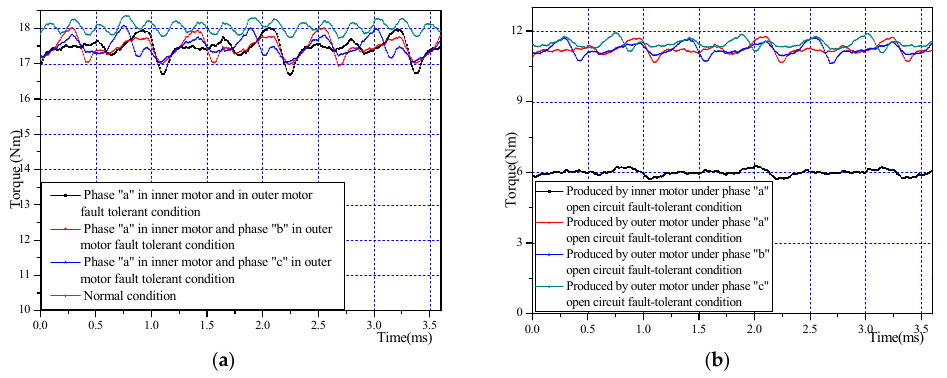
Figure 17. Single ‐ phase open ‐ circuit fault types in both inner motor and outer motor. ( a ) Same phase in inner motor and out motor are open open ‐ circuit; ( b ) “adjacent phase” in inner motor and out motor are open open ‐ circuit; ( c ) “non ‐ adjacent phase” in inner motor and out motor are open open ‐ circuit.